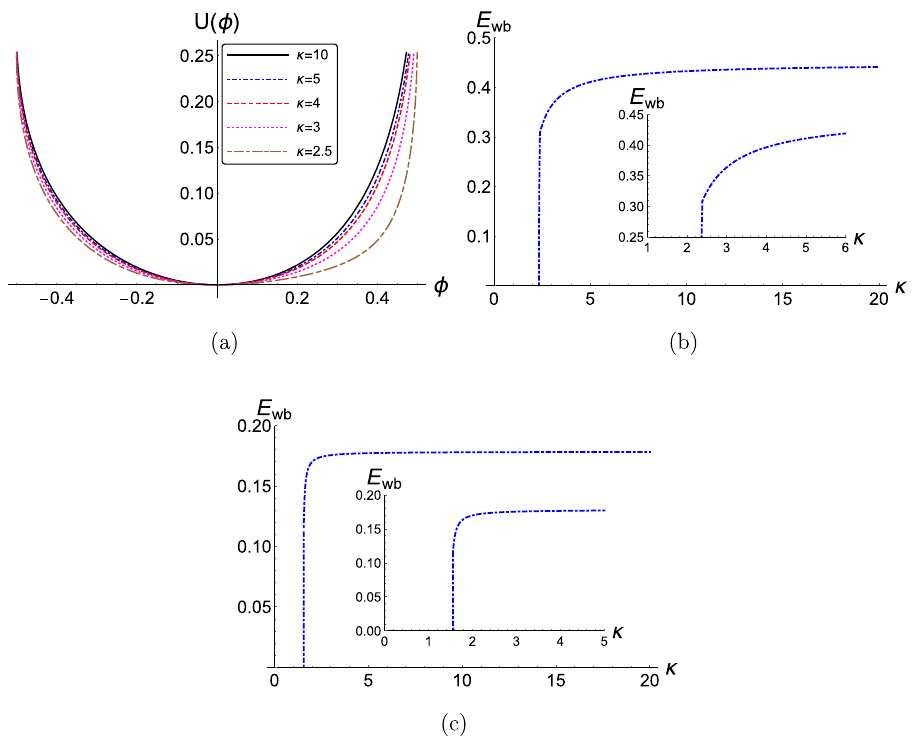
Figure 1. (Color online) ( a ) The effect of the variation of the superthermality index κ on the pseudopotential U (φ) is depicted versus the electrostatic potential φ for M = 1 . ( b ) The variation of the wave-breaking limit (electric field amplitude) E wb is depicted versus the value of the spectral (superthermality) index κ . ( c ) As the previous panel, but shifting the value of M to 0.3 (all other parameter values being the same). The parameter values adopted in these graphs are: δ = 0.5 , µ = 1 , and Q = 1 . The numerical values adopted here, as imposed by the maximum allowed value(s) of U (φ) , i.e. U max = I , are presented in Table I (see Online Appendix